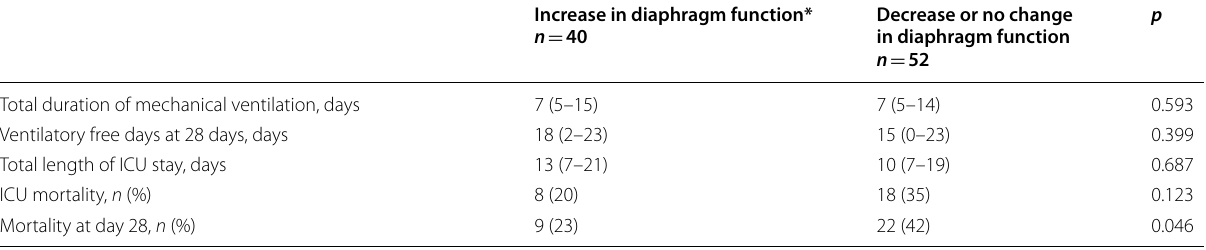
Categorical variables are expressed as absolute value (%) and continuous variables as median (interquartile